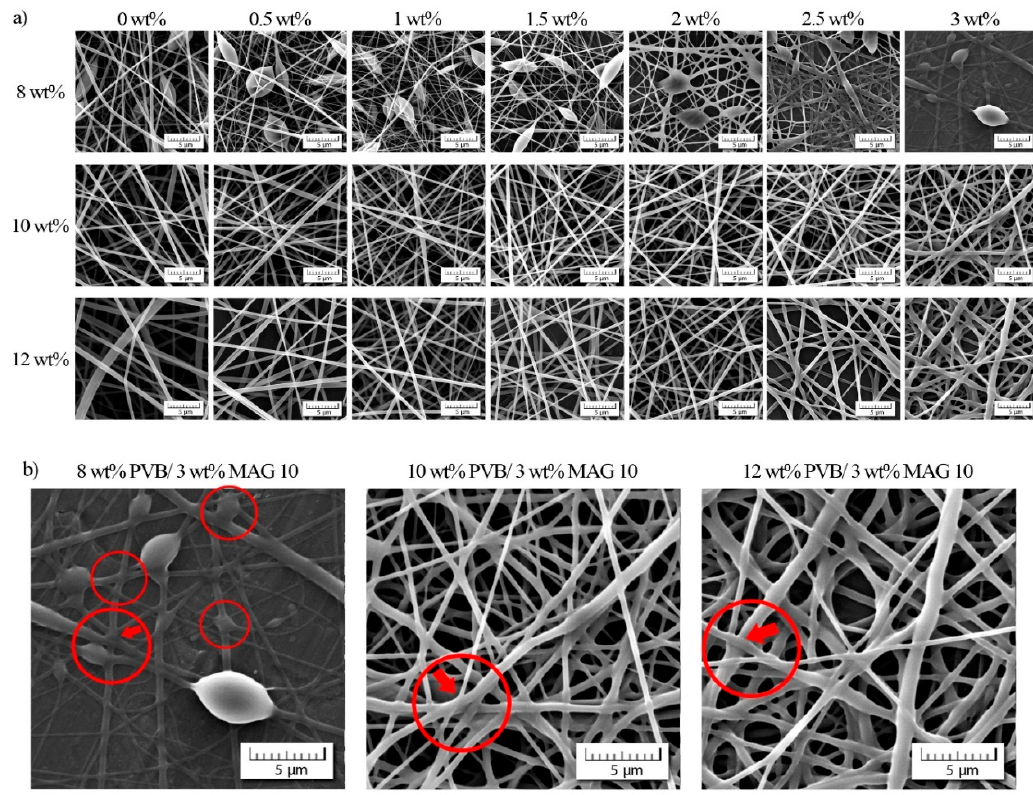
Figure 3. ( a ) Scanning electron microscope (SEM) images of the neat PVB and PVB / MAG 10 solutions, and ( b ) detail of fiber deformation.